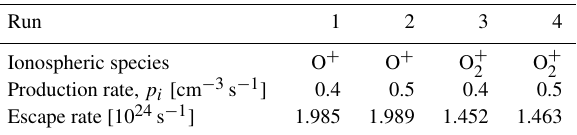
Table 2. The different best fit simulation runs, the ionospheric ion species, the maximum ionospheric production rates, and the result- ing escape